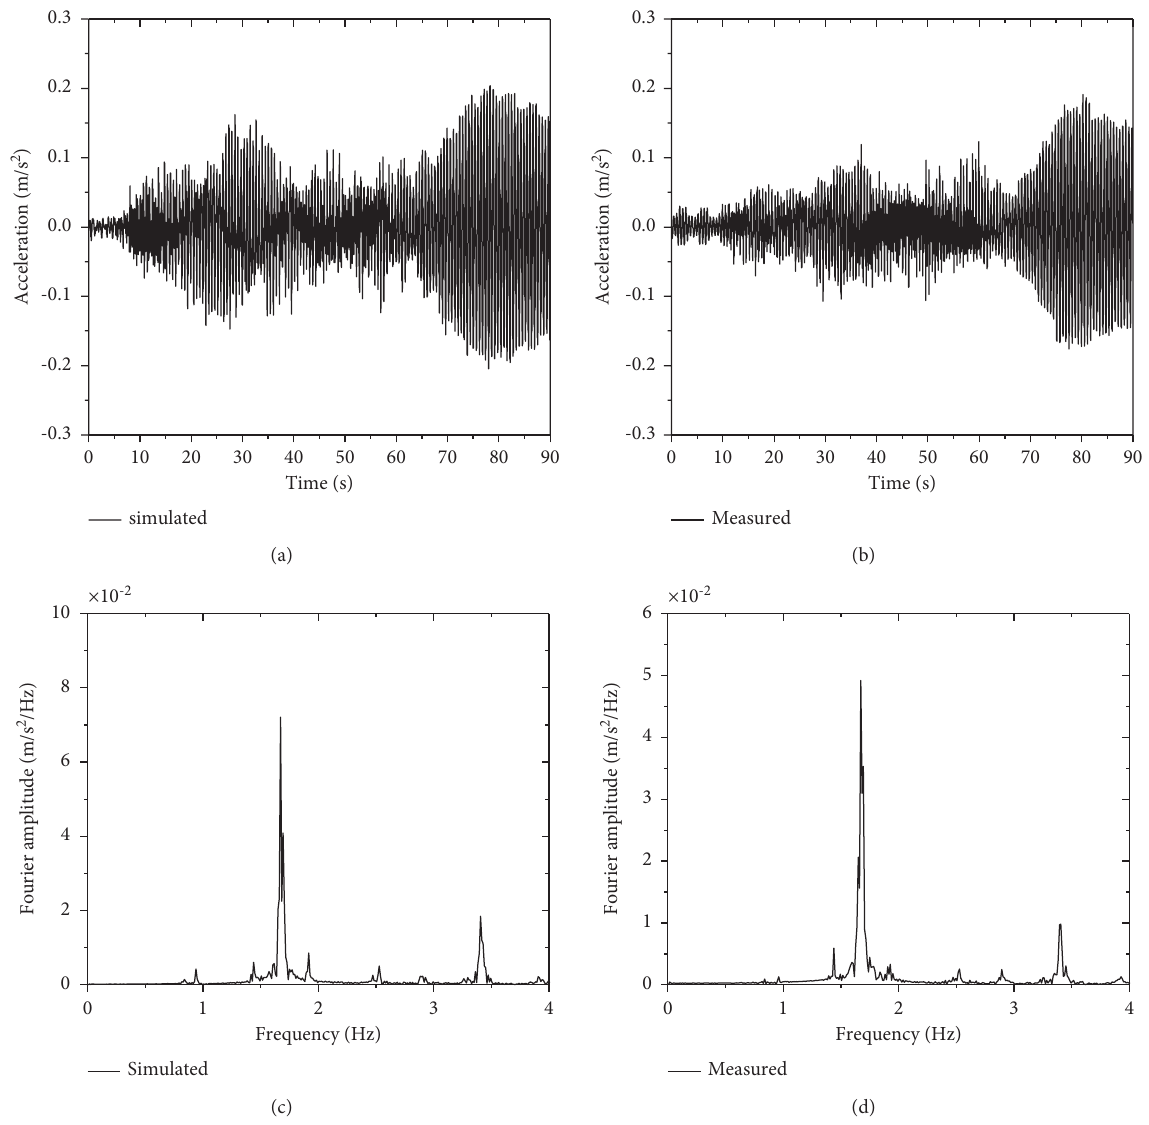
Figure 20: Comparison between simulated and measured bridge acceleration at the center of the main span: (a) simulated time history; (b) measured time history; (c) simulated spectrum; (d) measured